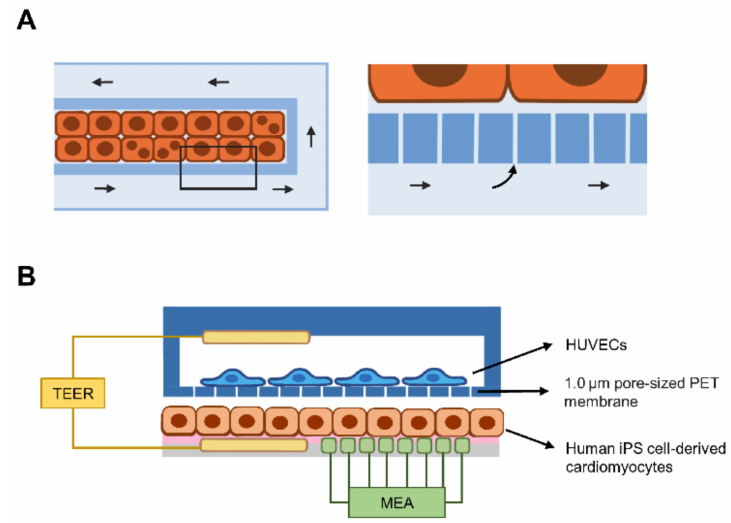
Figure 2. Current liver-on-a-chip models for hepatotropic infectious diseases and a combination of biosensors and organs-on-chip. ( A ) The microfluidic chip contains two compartments: a microcham- ber for hepatocyte culture (orange-colored rectangles) and microchannel (light blue) for fluid flow (arrows). The magnified box shows the porous layer that recapitulates the fenestration of SECs and allows the diffusion of culture medium into the cell-filled microchamber. ( B ) Coculture of human iPS cell-derived cardiomyocytes and HUVECs in double microchambers. Human primary hepatocytes (orange-colored rectangles) are grown on the fibronectin-coated surface (pink) of the lower chamber, while HUVECs are grown on the porous PET membrane of the upper chamber. The transepithelial electrical resistance (TEER, yellow) electrode is inserted into the upper and lower chambers. Gap for- mation between endothelial cells causes a decrease in TEER. Moreover, a multielectrode array (MEA) can be inserted in the lower chamber to detect the beating rate of cardiomyocytes.